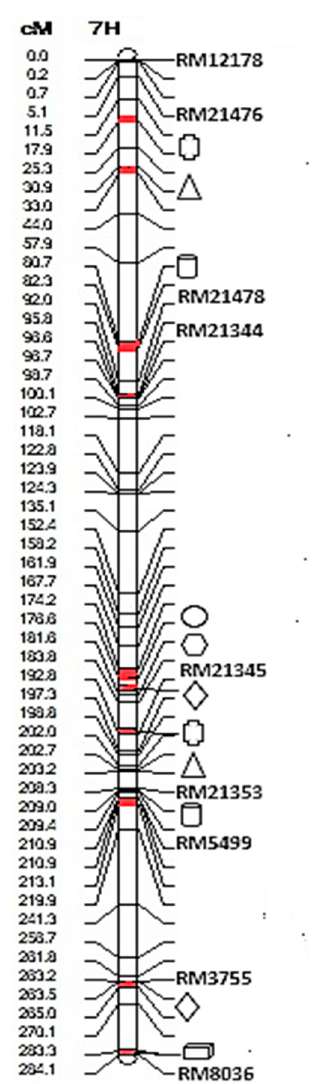
Figure 2. This figure shows the location and congregation of QTL affecting cold stress tolerance in NILs populations of Japonica rice. These QTL of RSS ( ), BG ( ), ILBS ( ), ULL ( ), RSLL ( ), FG ( ), and 1-2IL ( ) are located on chromosome number 7.